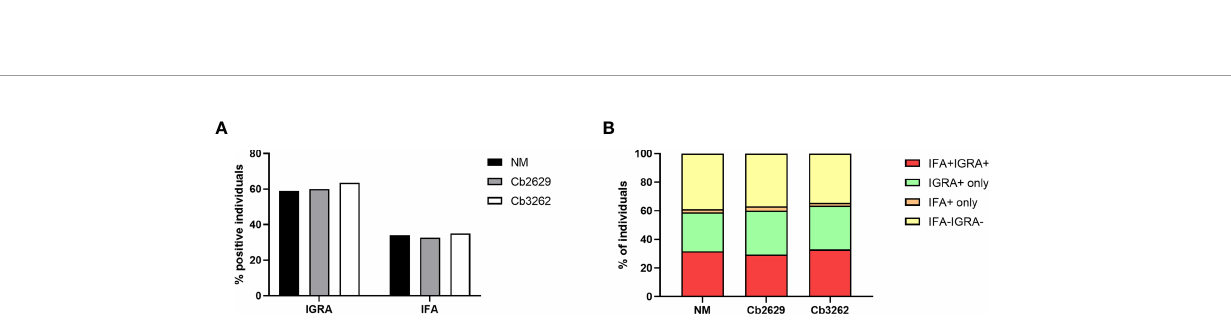
FIGURE 2 | Proportion of donors tested positive by IFA and IGRA. The proportion of samples testing positive by IFA and/or IGRA is shown per group for donors with conclusive IGRA results (n=1420 for NM, n=805 for Cb2629 and n=685 for Cb3262). (A) Total proportion of IGRA+ and IFA+ donors per group. (B) Proportion of donors with responses by IGRA and IFA; IGRA only; IFA only or